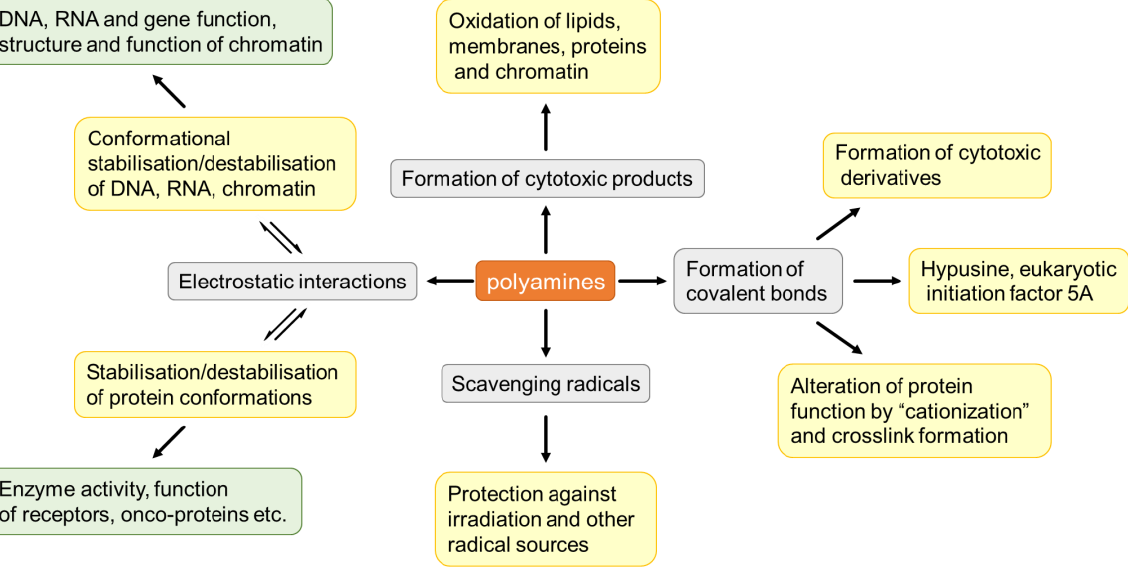
Figure 6. Apoptotic pathways that alteration of endogenous polyamine levels may involve. Adapted from ref. [239].